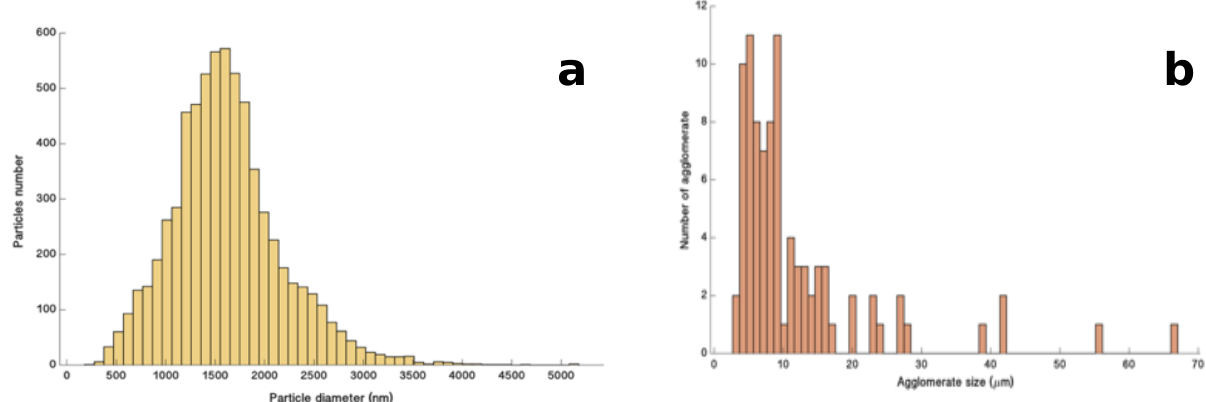
Figure 2. Size distributions of Titan’s tholins made from 19 images captured with SEM, then processed using a semi- automated code written for this study, detecting circular shapes using the Hough transform, and thus determining the diameter of spherical particles (with a visual check). Distribution ( a ) accounts for 6692 monomers in total. The distribution ( b ) takes into account 90